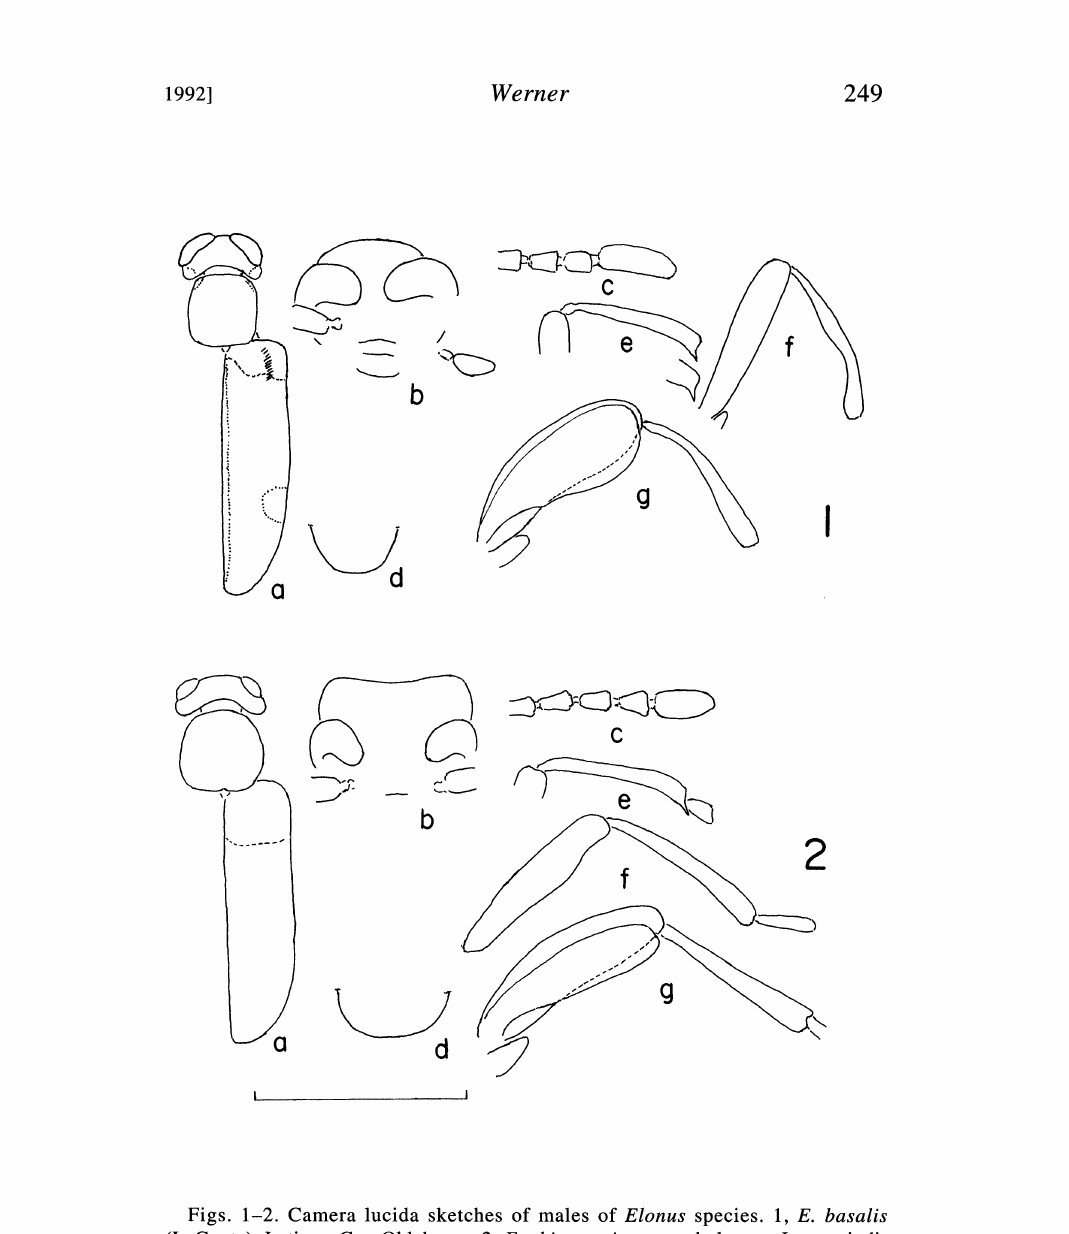
Figs. 1-2. Camera lucida sketches of males of Elonus species. 1, E. basalis (LeConte), Latimer Co., Oklahoma. 2, E. chisosensis, sp. n., holotype. Letters indi- cate: a, dorsal habitus; b, facial view of head; c, terminal antennal segments; d, lobe of abdominal plate on true sternum 6; e, front leg; f, middle leg; g, hind leg. Scale 2 mm for a, mm for